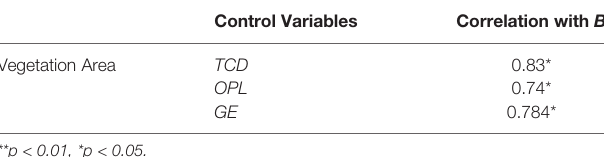
TABLE 4 | Partial correlation analysis relating geometric mean bifurcation ratio and vegetation area to different drainage ef fi ciency